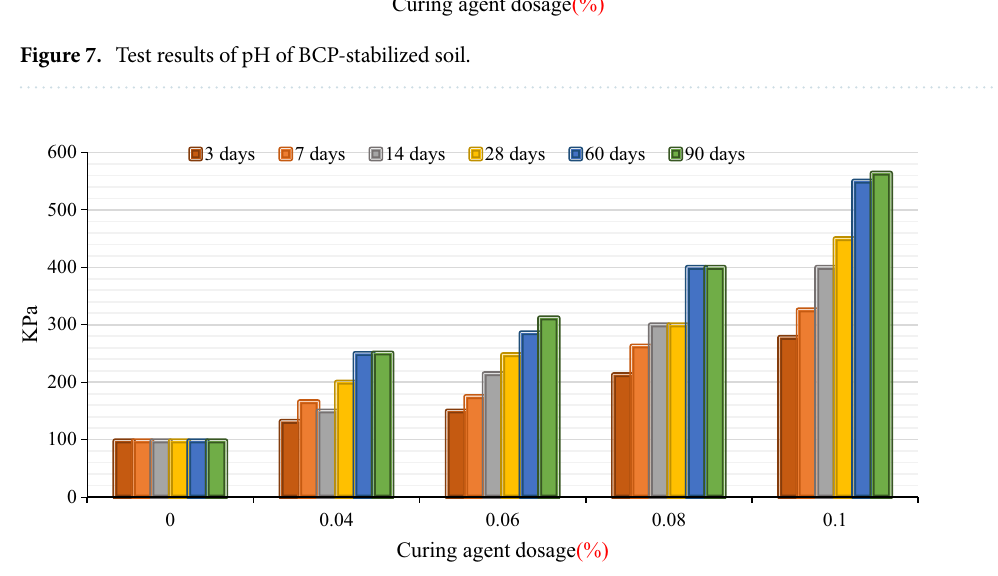
Figure 8. Unconfined compressive strength of BCP-cured